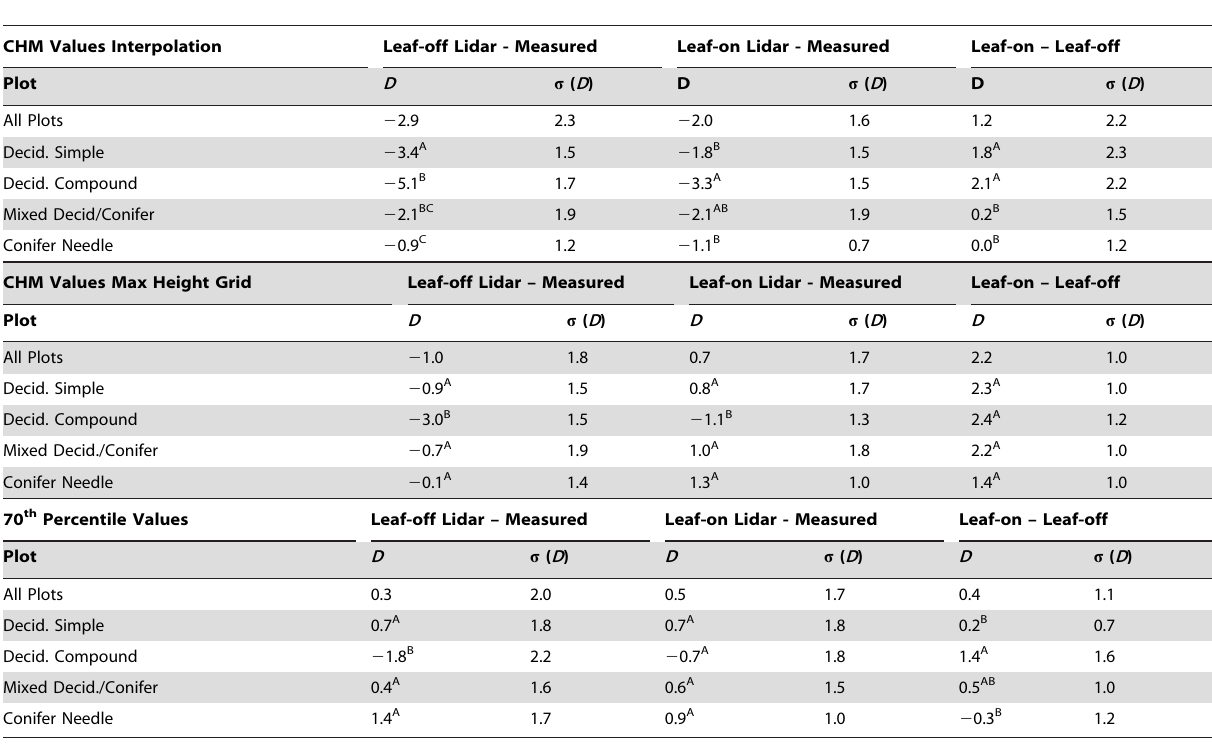
Table 4. Mean differences in meters (Lidar - measured plot average height) for all plots and plots stratified by vegetation type using both percentile and CHM lidar height